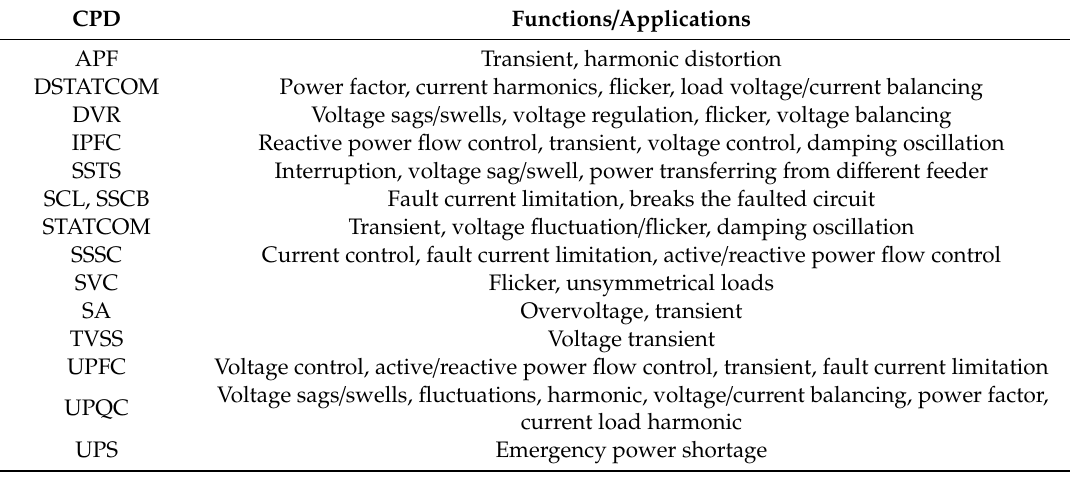
Table 4. Custom Power Devices (CPDs) and their functions / applications. Based on data from [30,31].